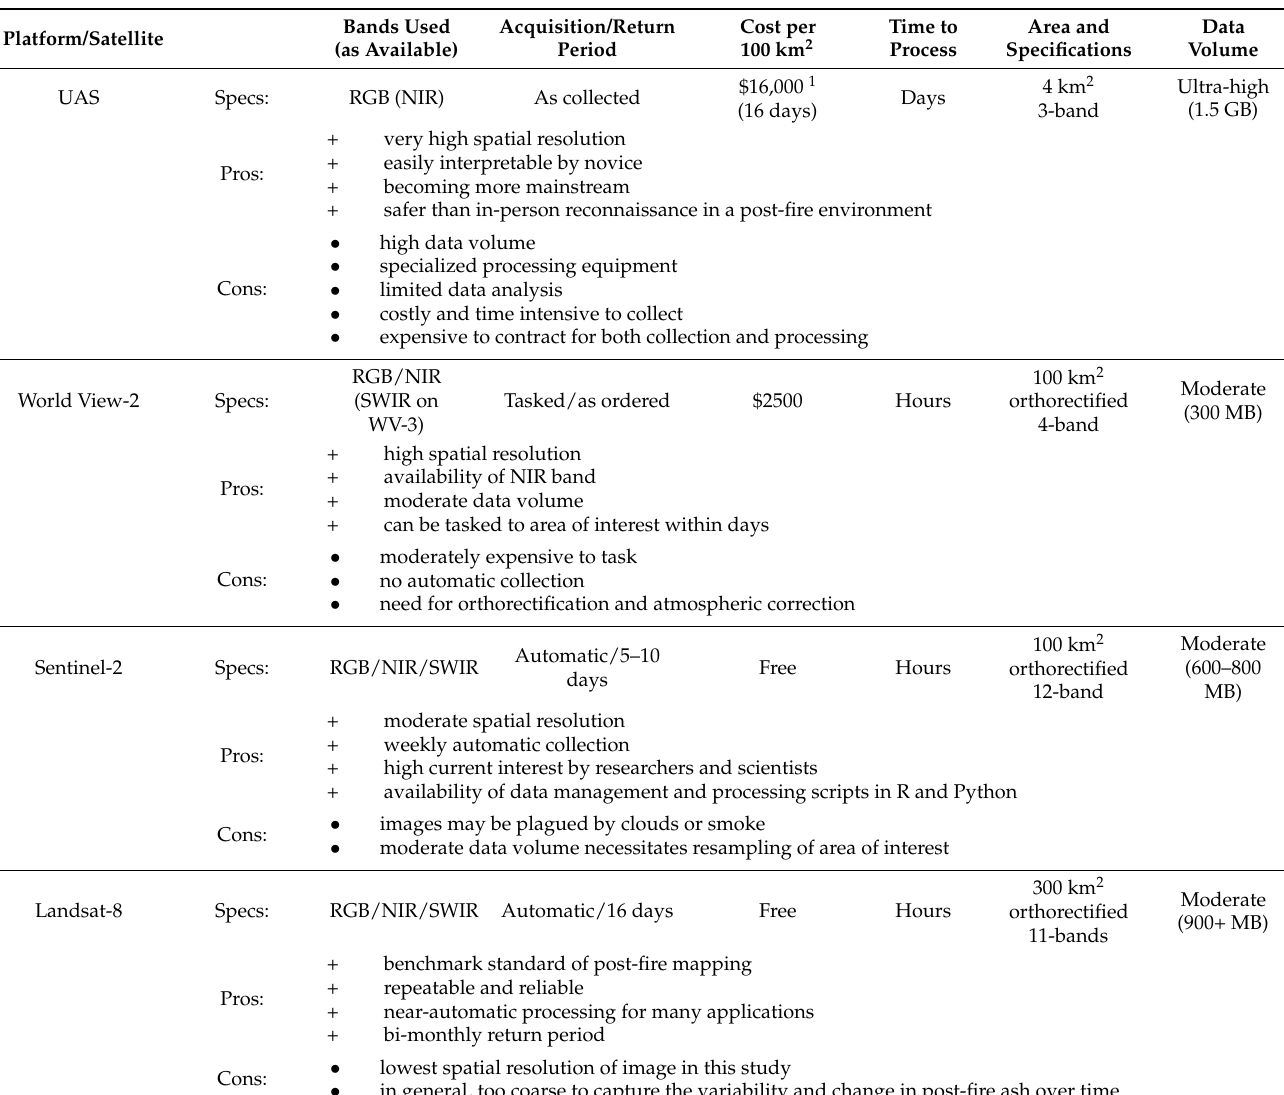
Table 5. Post-wildfire ash mapping cost–benefit considerations with image extent approximately normalized to 100 km 2 .